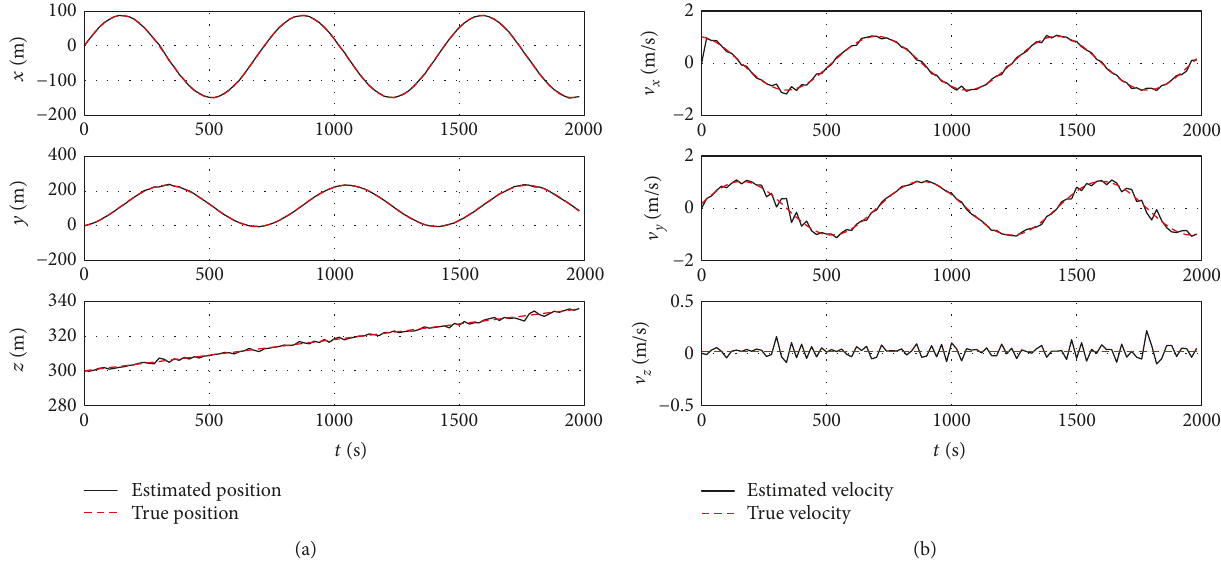
Figure 7: Comparison of the true and estimated values in general formation. (a) True and estimated position. (b) True and estimated velocity.